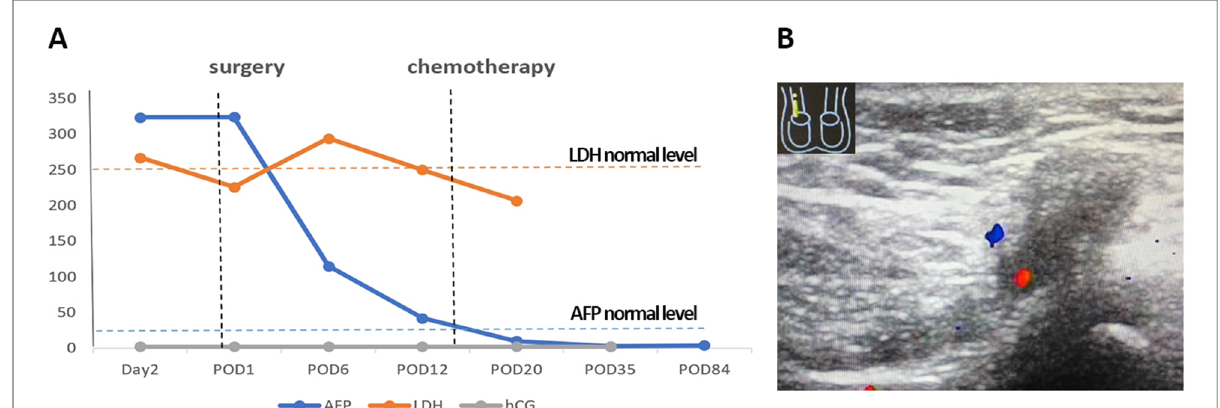
FIGURE 3 The results of postoperative reexamination. ( A ) The line graph of serum AFP, LDH, and HCG levels changes in the perioperative and chemotherapeutic period. ( B ) The results of reexamination of color Doppler ultrasonography showed hypoechoic and bloodless legion in right inguinal legion. POD, postoperative day. AFP, α -fetoprotein; LDH, lactate dehydrogenase; HCG, chorionic